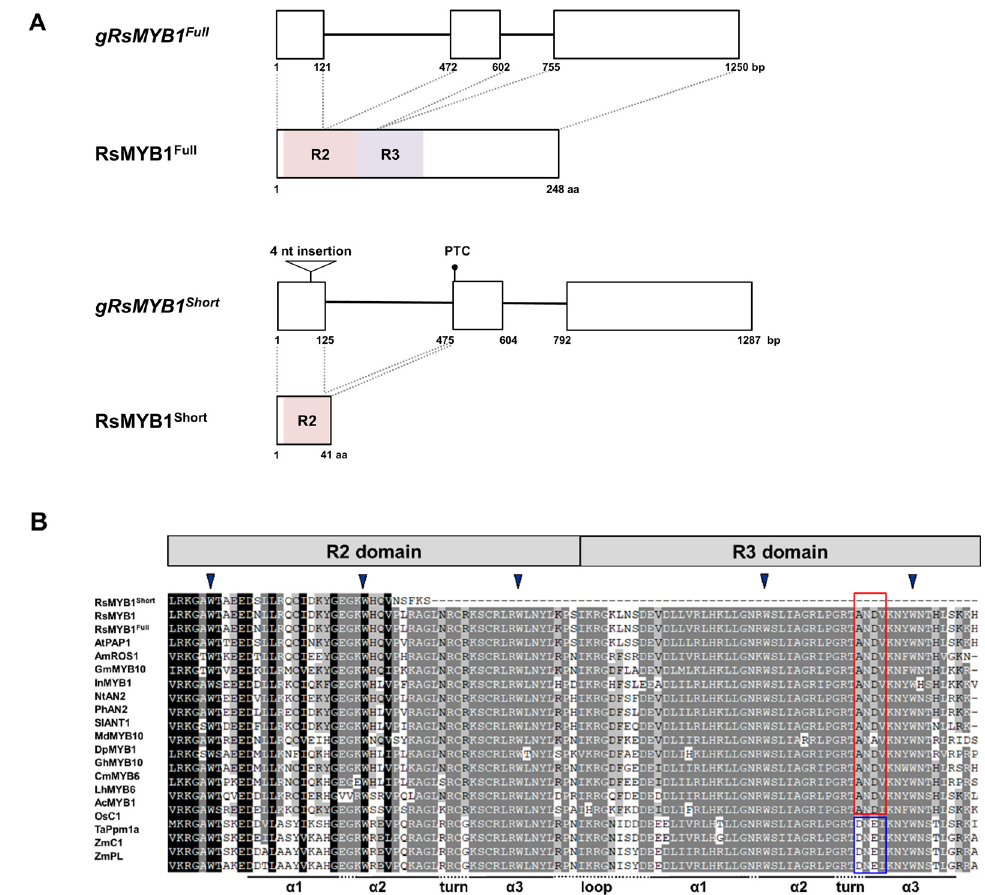
Figure 3. Genomic structure of RsMYB1 alleles and phylogenetic tree of RsMYB1 proteins from red and white radish cultivars and R2R3 MYB proteins from other plants. ( A ) Schematic diagram of the genomic structure of RsMYB1 . The predicted protein encoded by each mature mRNA is indicated below with their functional domains. White boxes, exons; black lines, introns. The 4 bp insertion site in RsMYB1 Short is indicated by a triangle. Premature termination codon (PTC) is indicated by a circle. ( B ) Multiple protein sequence alignment of the R2 and R3 domains across R2R3 MYB proteins from other plants. The conserved residues of the DNEI and ANDV motifs are shown in the red and blue boxes, respectively. Inverted blue triangles indicate the conserved residues forming the inner hydrophobic core of the R2 and R3 domains.